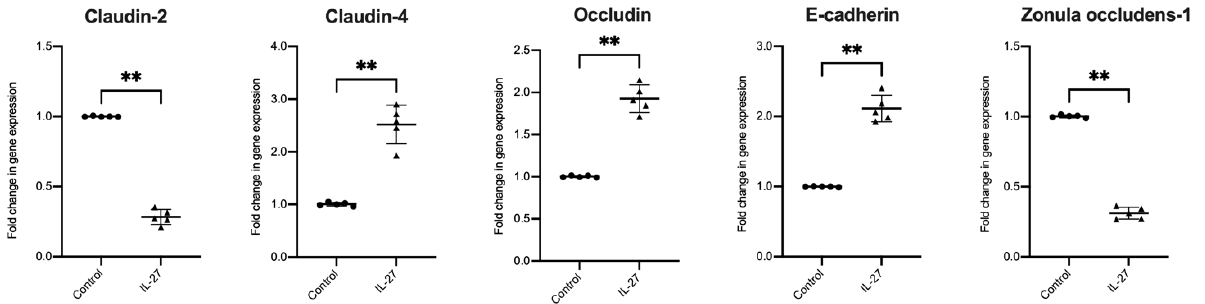
Figure 2. IL-27 effect on human gastrointestinal colonic organoid gene expression. RT-qPCR analysis of human patient-derived organoids stimulated with rhIL-27 (100 ng/mL) compared to unstimulated controls of epithelial barrier function genes. Expression normalised to GAPDH; n = 5 individual patient-derived organoids, with 3 technical replicates/experiment, presented as mean ± SD. Statistical analysis with Mann–Whitney U test. * p < 0.05, ** p < 0.01, *** p < 0.001 and **** p < 0.0001; ns = not significant.